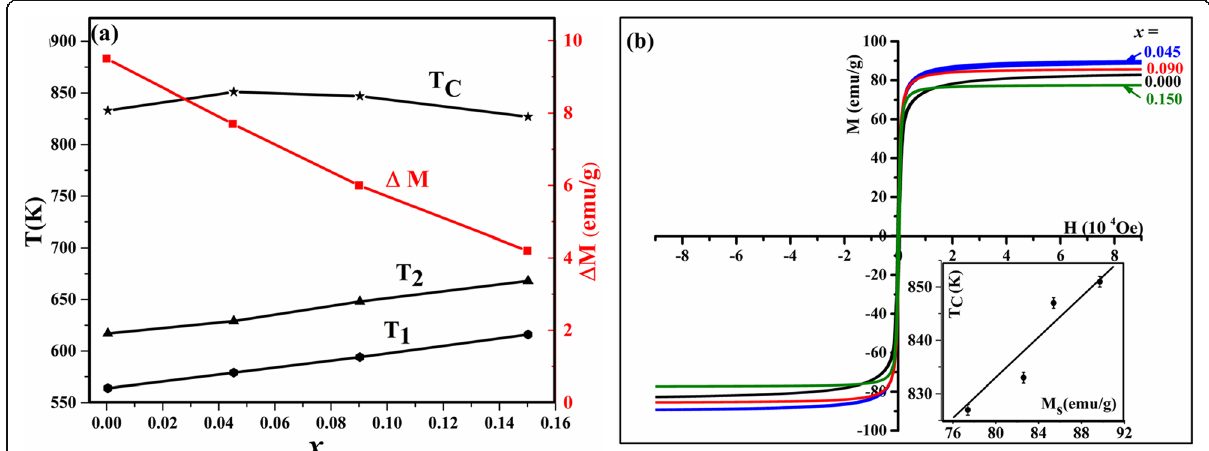
Fig. 2 a T 1 , T 2 , Δ M , and T c values obtained during 1st heating regime and b hysteresis loops for different amount of x for Sn x Fe 3-2/3 x O 4 nanoparticles at 2 K (inset, the relation between Curie temperature and saturation